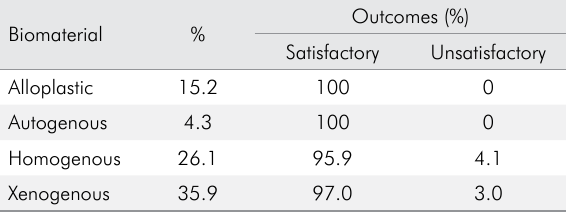
Table 2. Overview of Group P patients.